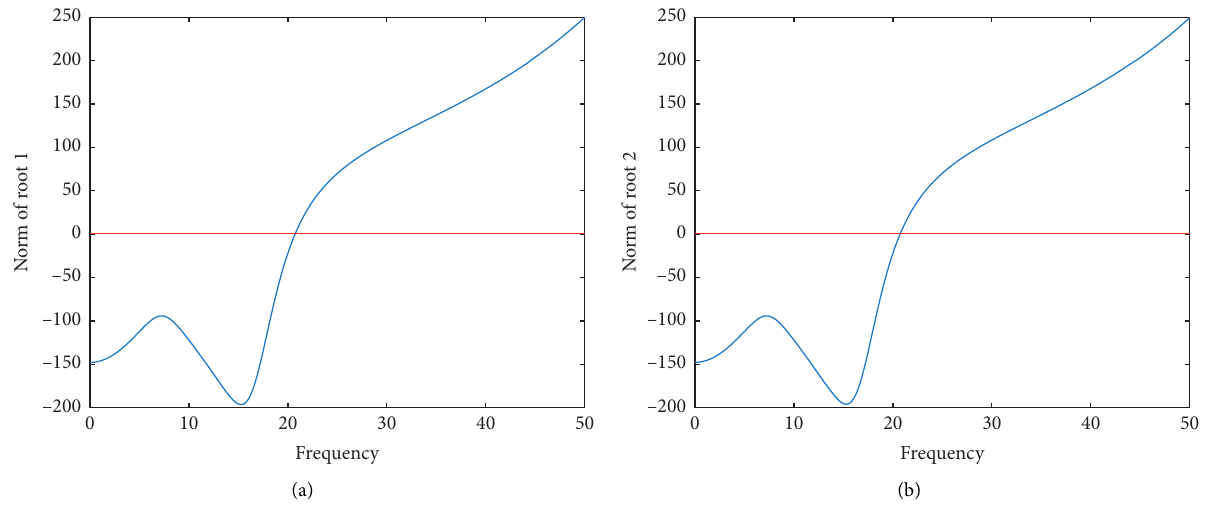
Figure 4: Modulus of Z in the characteristic equation. (a) Norm of root1. (b) Norm of